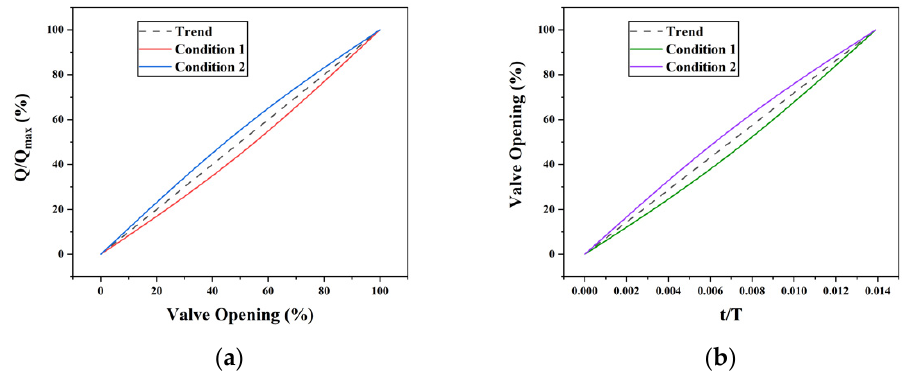
Figure 9. Characteristic curve of linear flow valve ( a ), and opening curve ( b ).